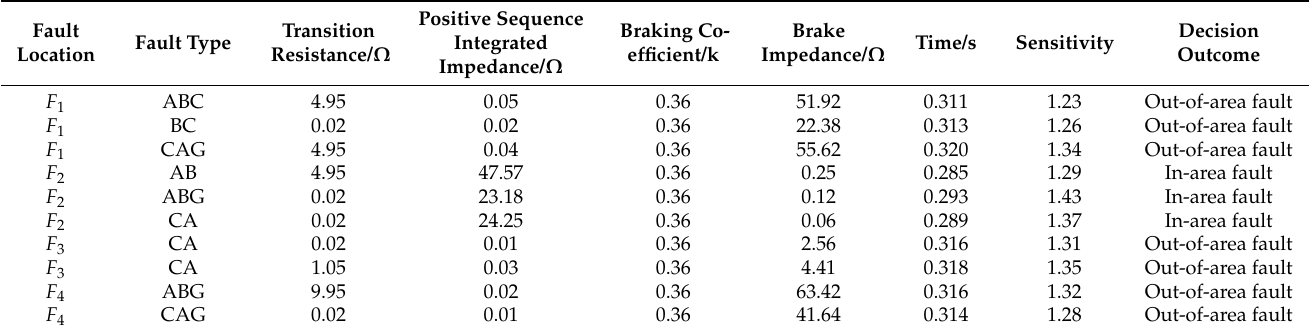
Table 3. Identification of line 10 protection at different positions and under different fault condi- tions.